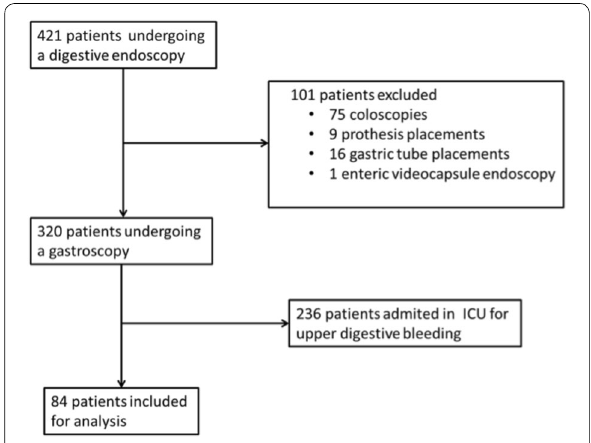
Fig. 1 Patient flowchart. During the study period, 3352